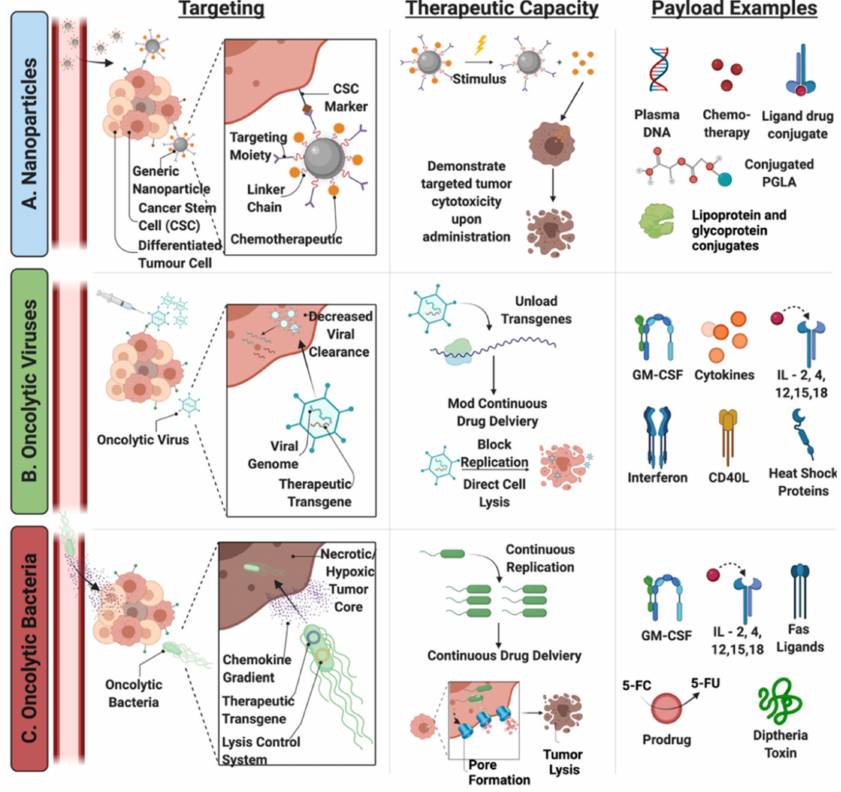
Figure 4. Comparison of payload delivery characteristics and capacity. ( A ) Nanoparticles use targeting motifs (e.g., cancer stem cell marker CSC) for specific targeting of tumor cells. Once localized, they will release their payloads with or without controlled stimuli [231,232]; ( B ) oncolytic viruses target tumors and take advantage of decreased viral clearance mechanisms. After they reach the cytosol, the virus will not only shed DNA/RNA transgenes resulting in constant replication, but they also block cellular replication or induce direct cell lysis. Examples of Oncolytic Viral payloads are depicted [70,102,104,144,146]; ( C ) Oncolytic bacteria migrate to tumor cells due to chemokine gradients. After reaching tumor cells oncolytic bacteria will either replicate within the tumor cell cytosol or further migrate to the hypoxic core before undergoing continuous replication and drug delivery. Examples of oncolytic bacteria drug delivery are shown for context